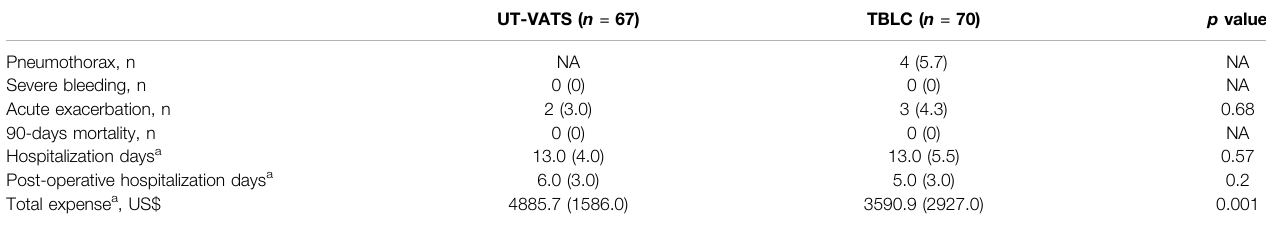
TABLE 5 | Complications and hospitalization costs for different biopsy